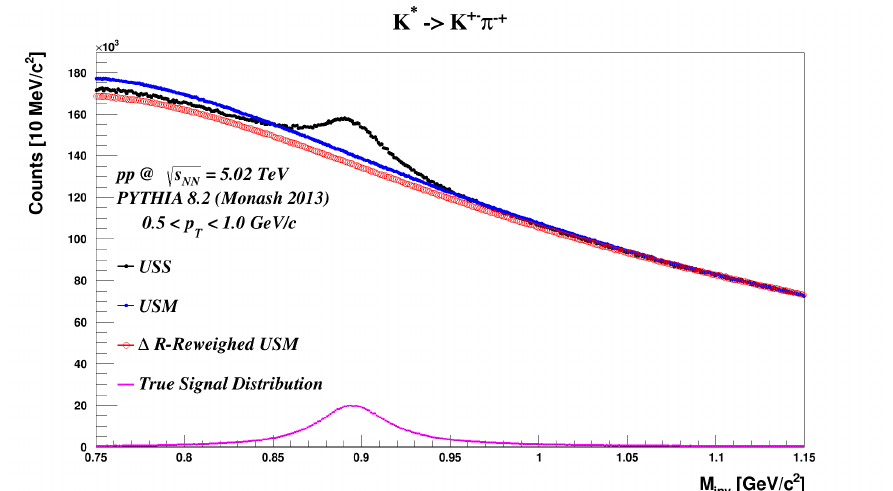
Figure 4. Comparison between the K*(892) resonance decay and an event-mixed background distribution. The pink distribution showcases the true signal